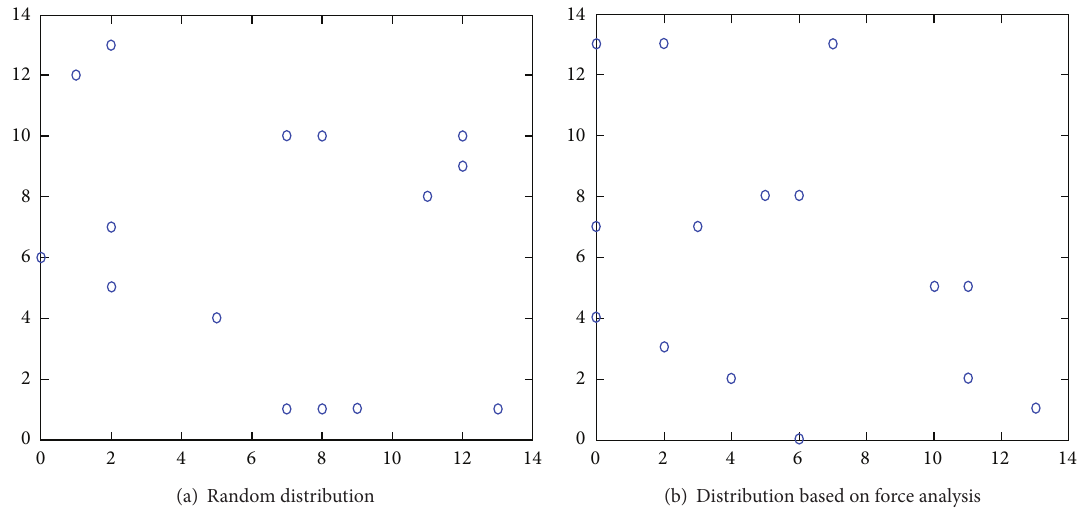
Figure 3: Distribution diagram of the subgraphs.